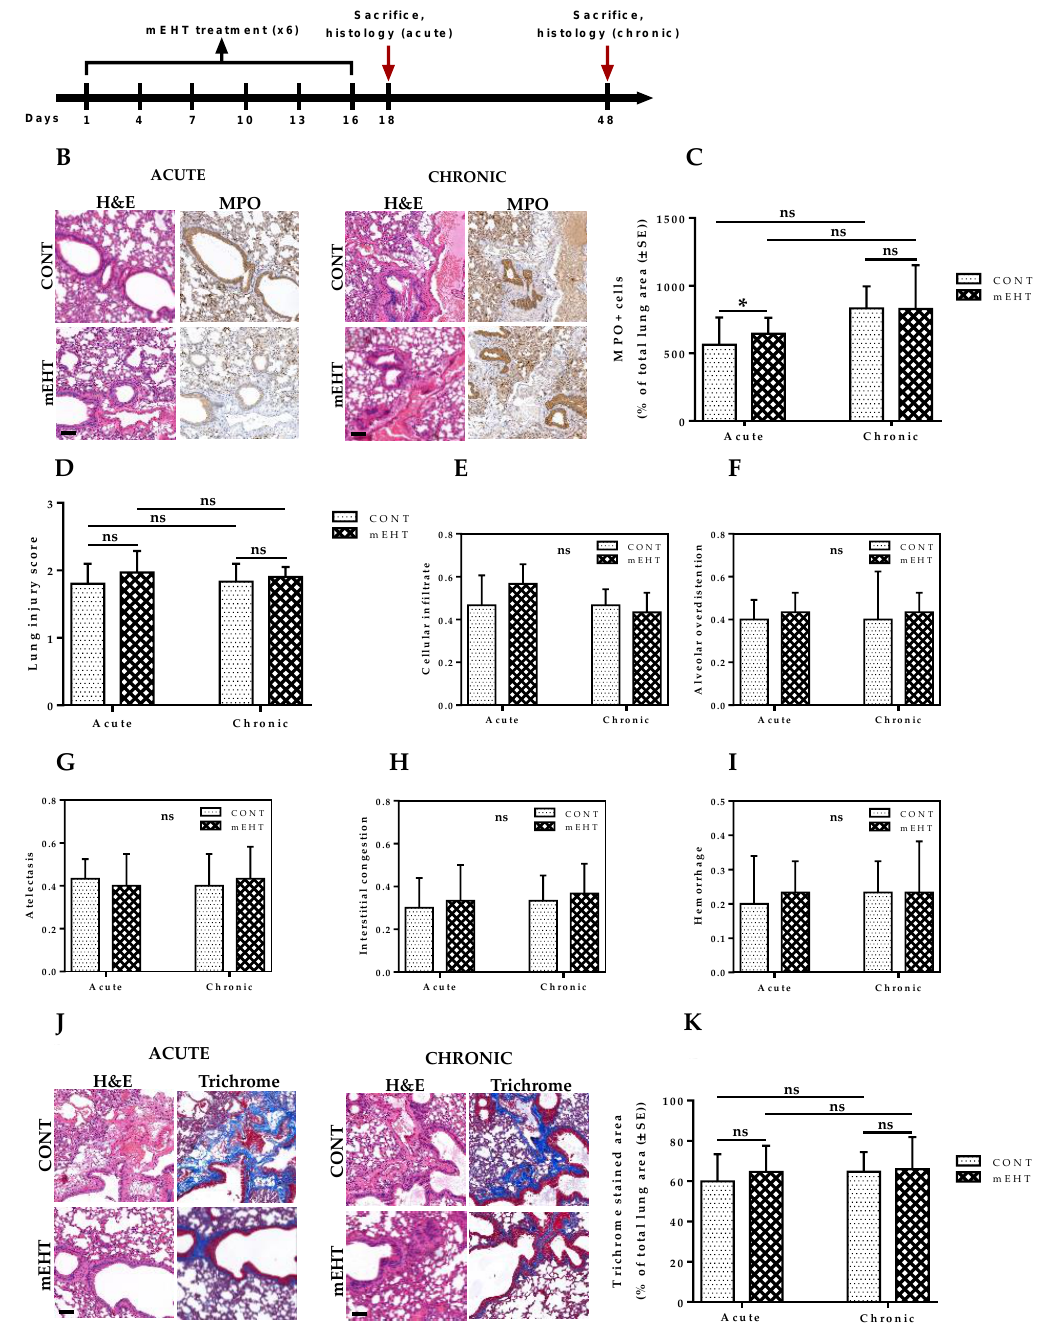
Figure 9. Acute and chronic treatment e ff ect of mEHT on lung inflammation, lung injury, and